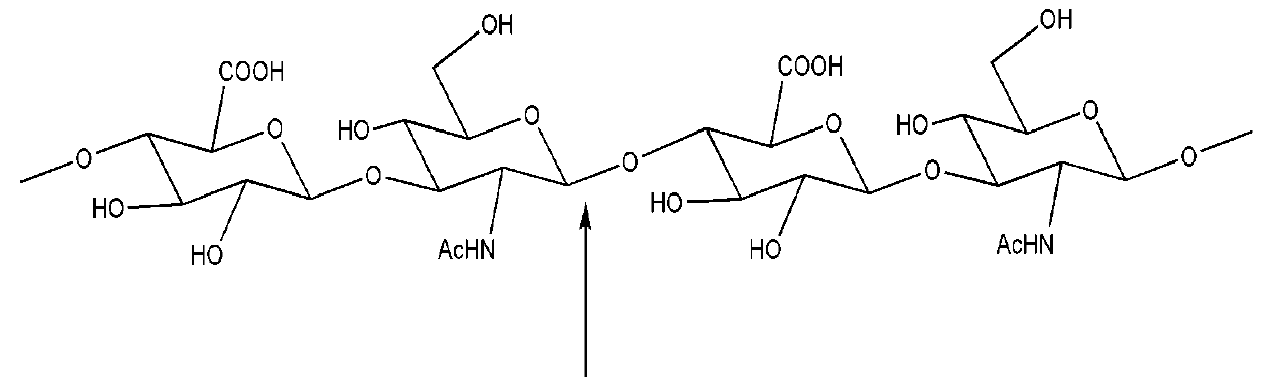
Figure 1. Tetrasaccharidic moiety of a hyaluronic acid chain and point of attach of hyaluronase for the hydrolysis and transglycosylation